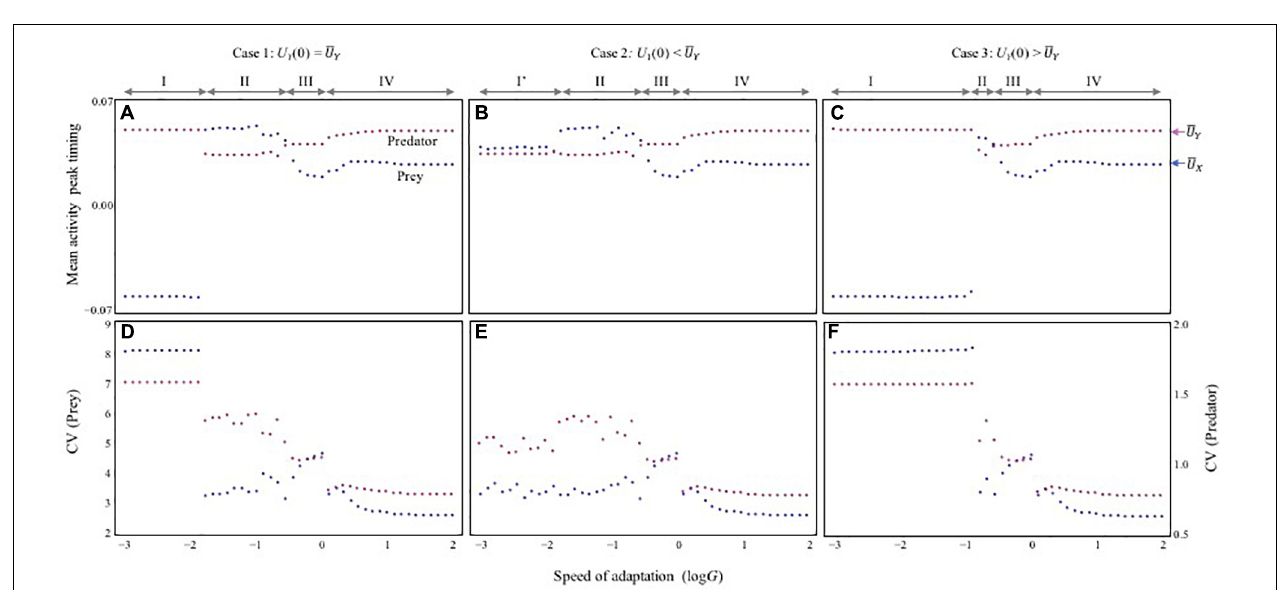
FIGURE 2 | The relationship between adaptation speed and stability of population dynamics. (A–C) Mean activity peak timing (mean trait values) (A–C) and stability of population dynamics (D–F) with varying speed of adaptation. The stability is evaluated by the coefficient of variation (CV) of population sizes during a certain period after sufficient time (t), which corresponds with the time taken for the dynamics to reach an asymptote (see section “Model” for details). Mean trait values are also calculated in the same period. Red and blue arrows shown in (C) represent values of physiological optimal activity peak timing, ¯ U Y and ¯ U X , respectively. In (d–f), red and blue represent the CV of predator (left vertical axis) and prey (right vertical axis), respectively. Parameters are the same as those of Figure 1 . Under different initial variable conditions, three cases are observed. I checked whether bi-stability occurs by systematically changing initial values of traits (within a range –0.1 < U i (0) < 0.1 with 0.01 increments). The three cases are based on the difference in the initial trait value of U Y (0). (A,D) U Y (0) = ¯ U Y . (B,E) U Y (0) < ¯ U Y . (C,F) U Y (0) > ¯ U Y . It is assumed that U X (0) = ¯ U Y = 10/365 and U Y (0) = ¯ U Y = 20/365 in (A,D) , U Y (0) = ¯ U Y -0.01 in (B,E) , and U Y (0) = ¯ U Y + 0.04 in (C,F) .